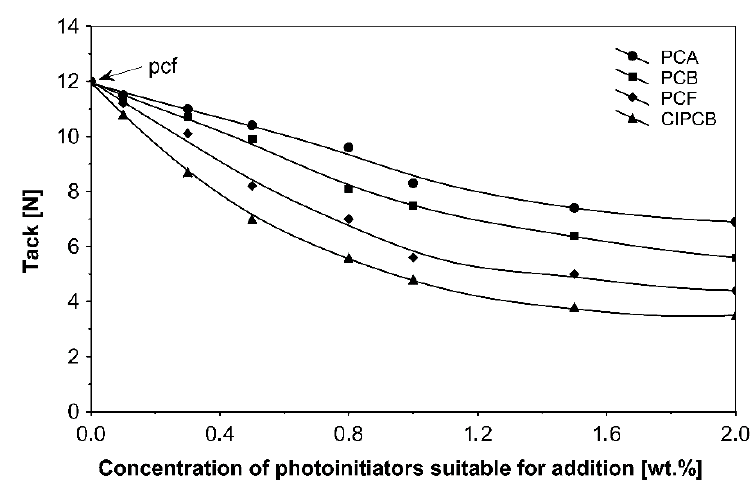
Figure 2. Tack of acrylic pressure-sensitive adhesives (PSAs) containing additionable photoinitiators after UV cross-linking .